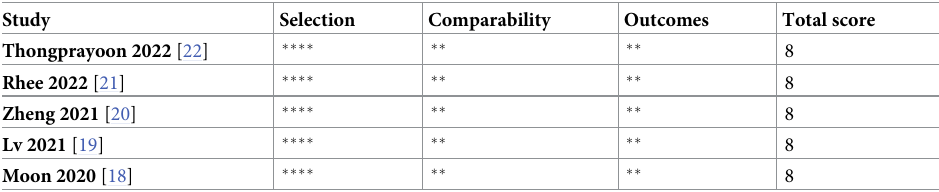
Table 3. Risk of bias